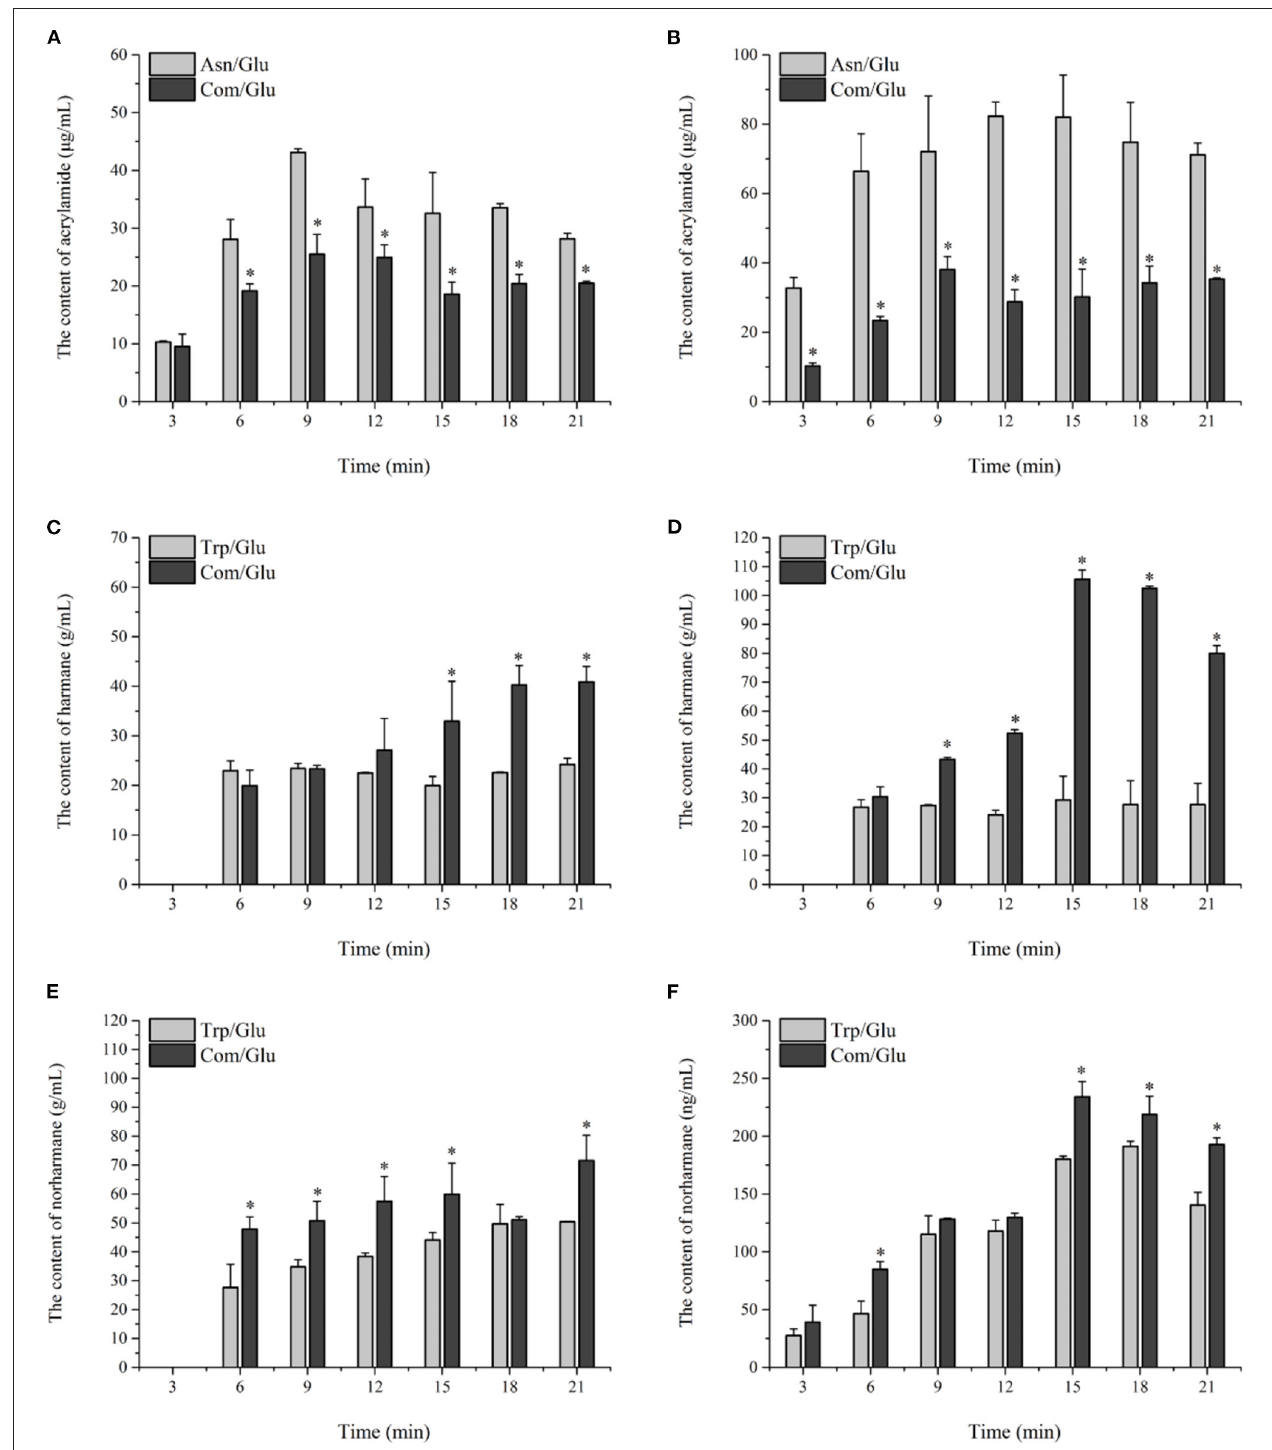
FIGURE 4 | Kinetic profiles of Maillard reaction products includes Acrylamide (A,B) , harman (C,D) , and norharman (E,F) in the different amino acid/glucose model system heated at 170 ◦ C (A,C,E) and 200 ◦ C (B,D,F) . Data were expressed as mean ± SD in triplicates ( n = 3), *, ( P < 0.05).